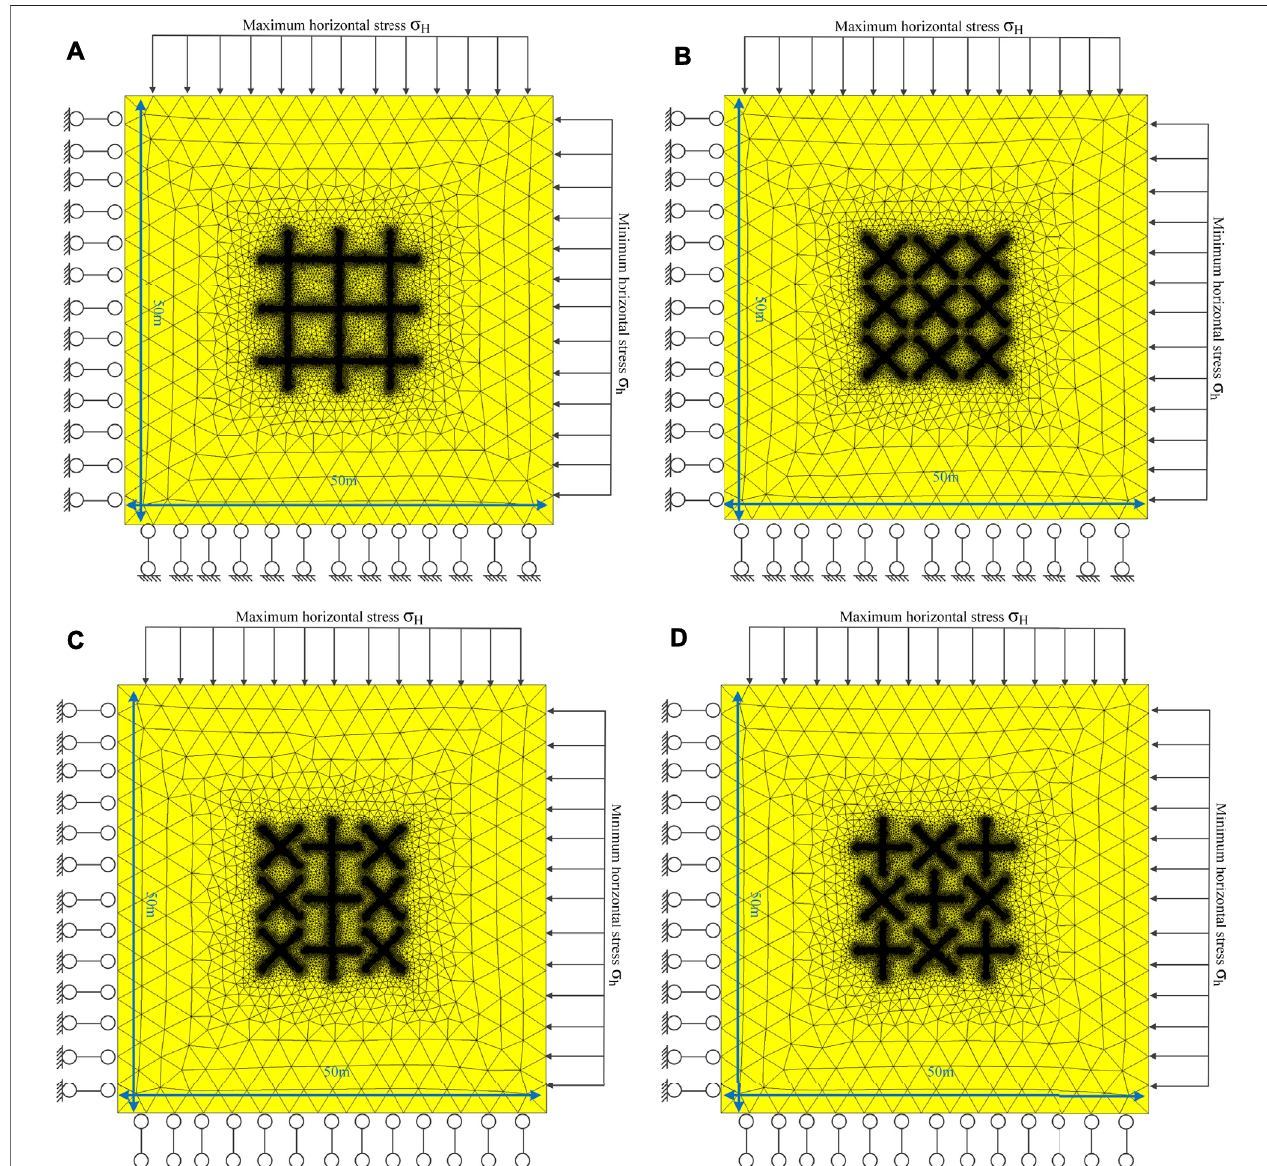
FIGURE3| Diagramshowingfourpossibletree-typesub-boreholecon fi gurationswhenfoursub-boreholesaredrilledfromeachmainborehole. (A) Squarelayout; (B) Rhombic layout; (C) Parallel mixed layout; (D) Cross mixed layout.